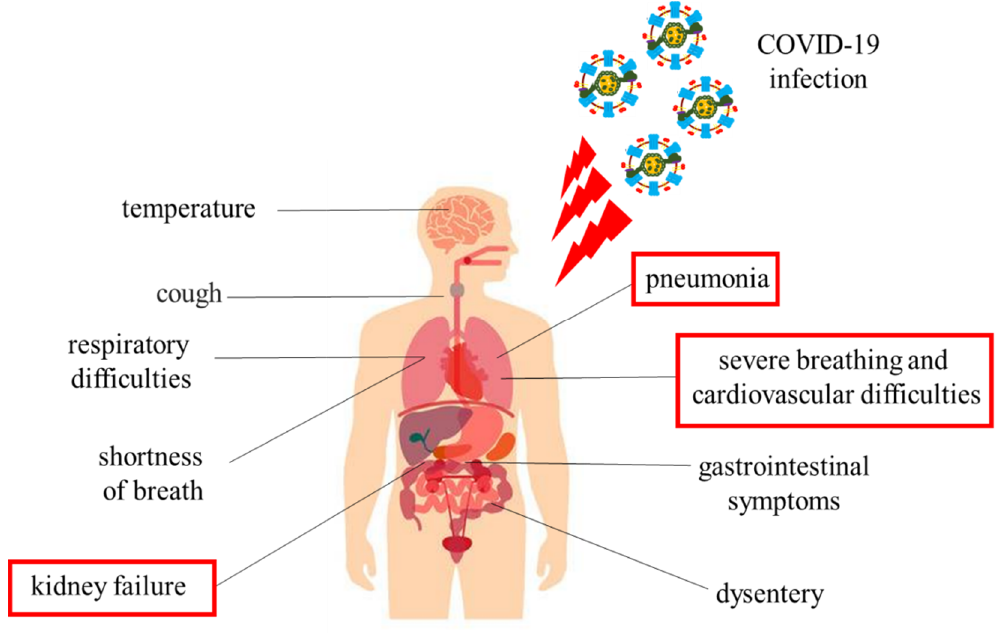
Figure 2. Symptoms of coronavirus.